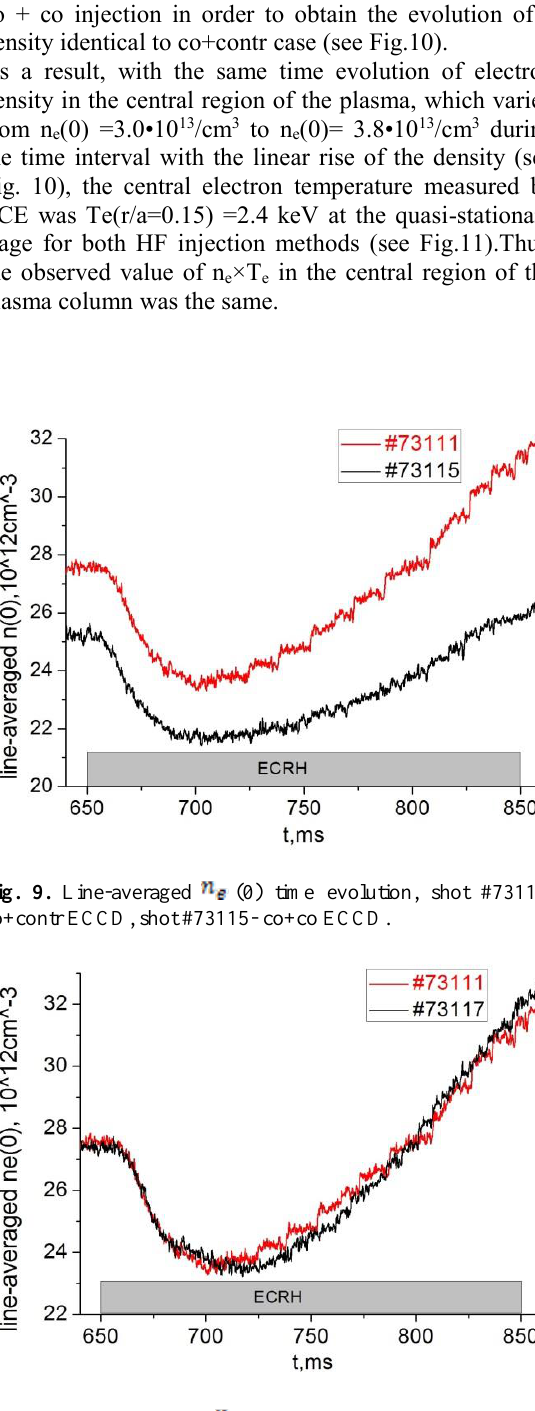
Fig.10. Line-averaged (0) time evolution. (#73111- co+contr),( #73117- co+co with additional gas-puffing).